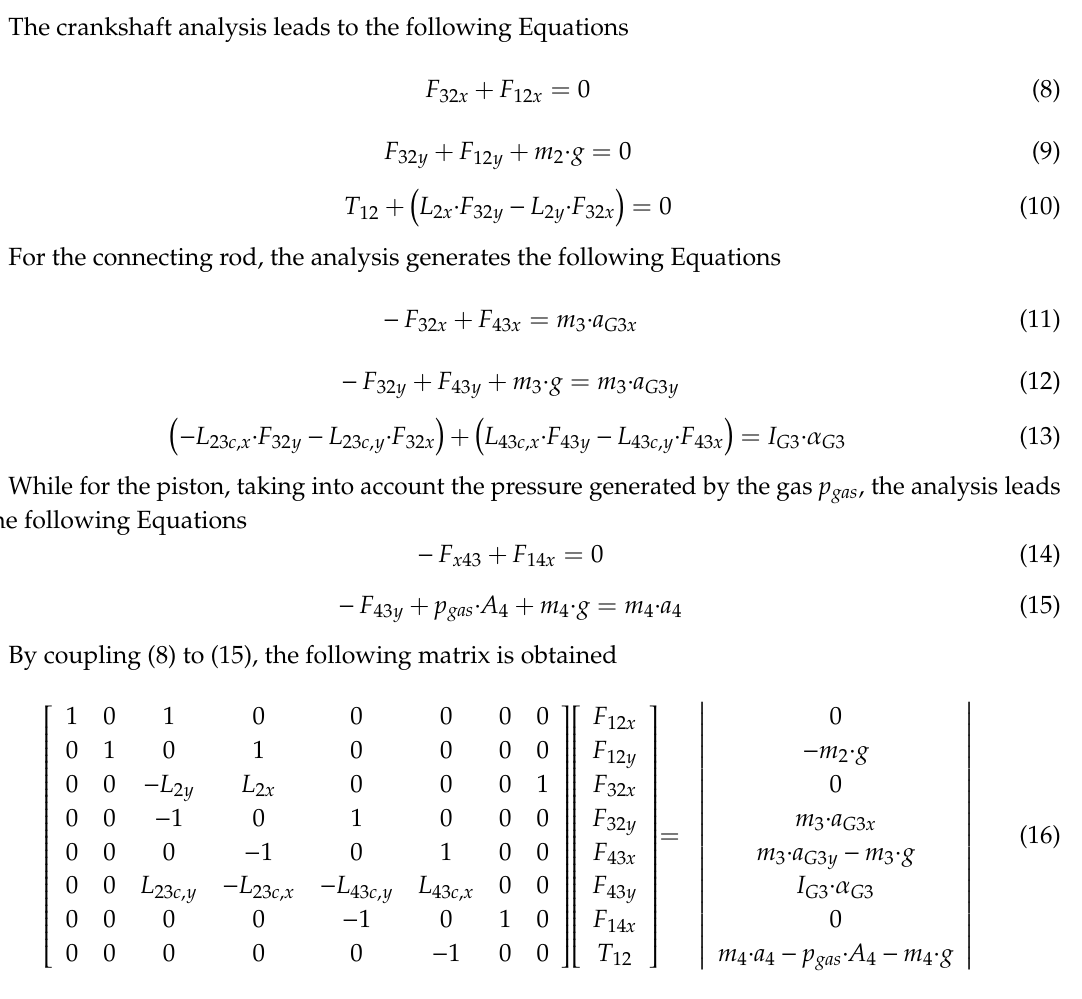
Figure 3. Free-body diagrams for ( a ) the crankshaft, ( b ) connecting rod and ( c ) piston.